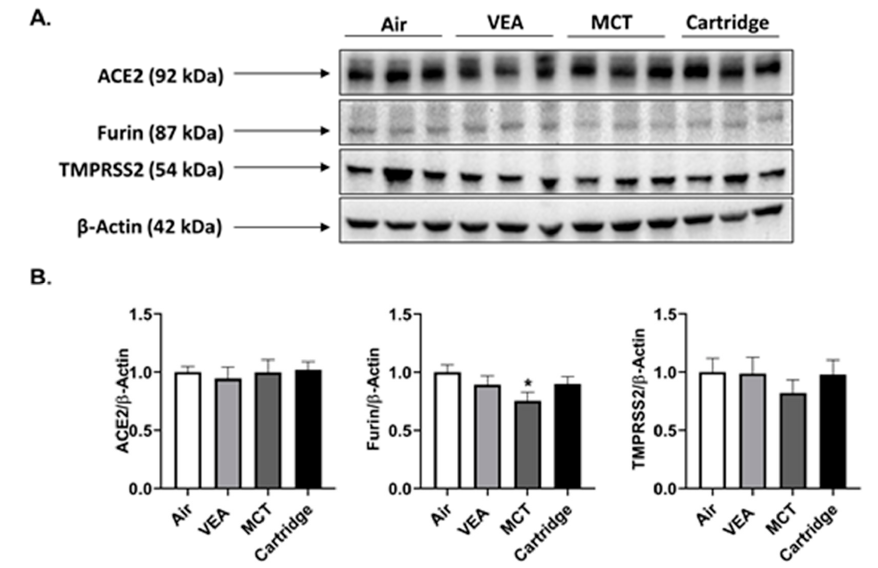
Figure 10. SARS-CoV-2 spike protein cleaving enzyme, furin, was reduced in MCT exposed in lung homogenates of male mice. After the three-day acute exposure to MCT, VEA, and cartridge aerosols, the abundance of ACE2, furin, and TMPRSS2 proteins were determined in mouse lung homogenates by immunoblotting assay. ( A ) Immunoblots for Ace2, furin, TMPRSS2, and β -actin. ( B ) Data represented as fold-change ± SEM * p < 0.05 vs. air. p > 0.05 were considered insignificant and were not denoted with asterisks (one-way ANOVA, n = 3 / group). The same blot was probed for ACE2, TMPRSS2, Furin, and SP-A. Thus, the same beta-actin band (for males) appears in both Figure 7 (SP-A) and Figure 10 (SARS-Cov-2 related